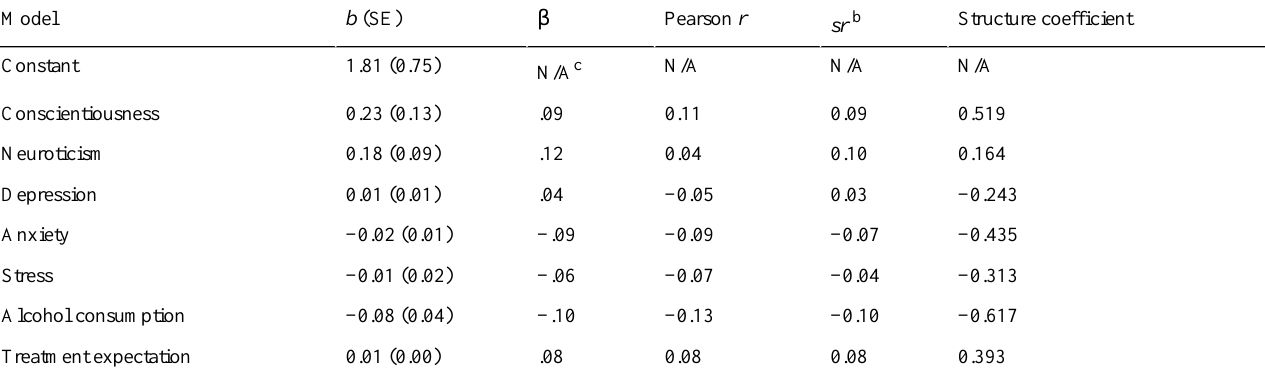
Table 4. Standard regression results for personality, negative affect, and treatment expectations predicting engagement with follow-up questionnaires (n=390) a